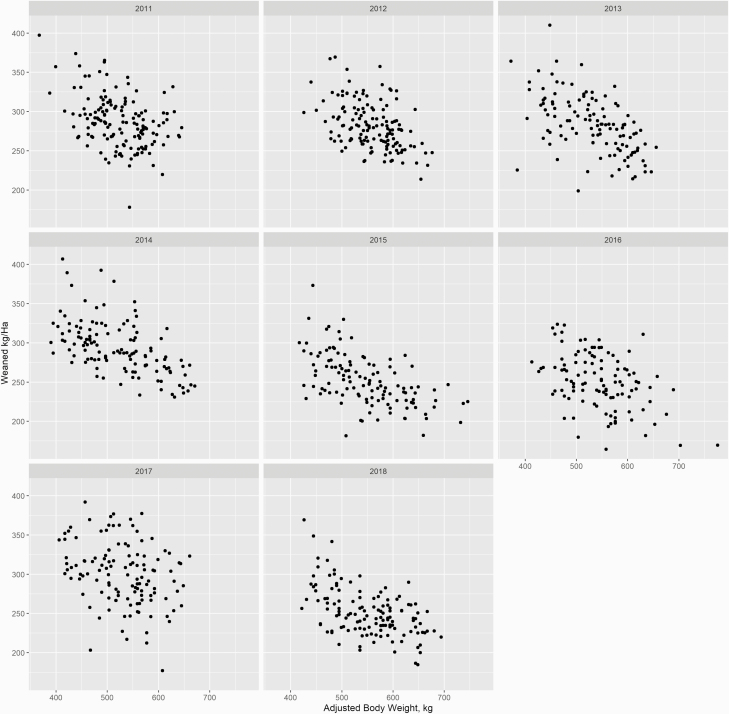
Weaned kg/ha plotted against adjusted cow body weight, by year for model herd.